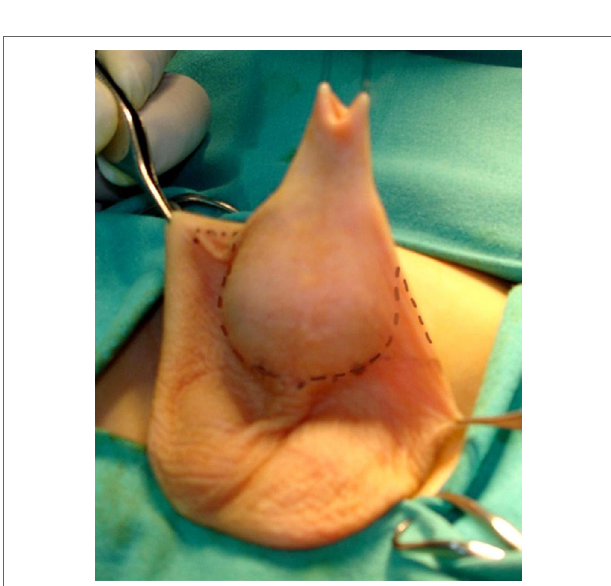
FigUre 3 | Inner preputial layer has been exposed via a ventral approach.